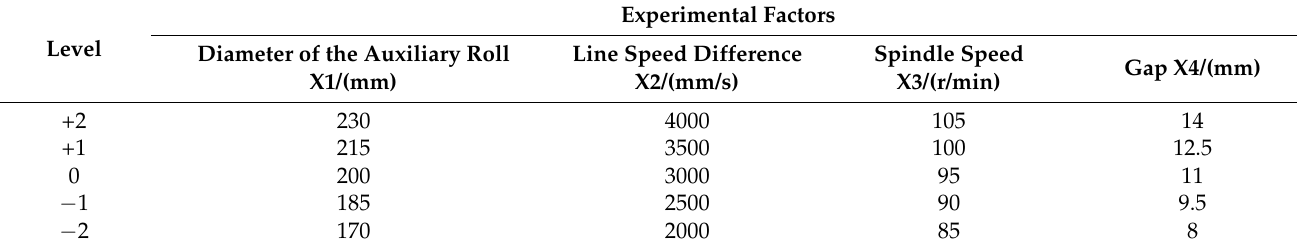
Table 3. Factor levels coding of central composite